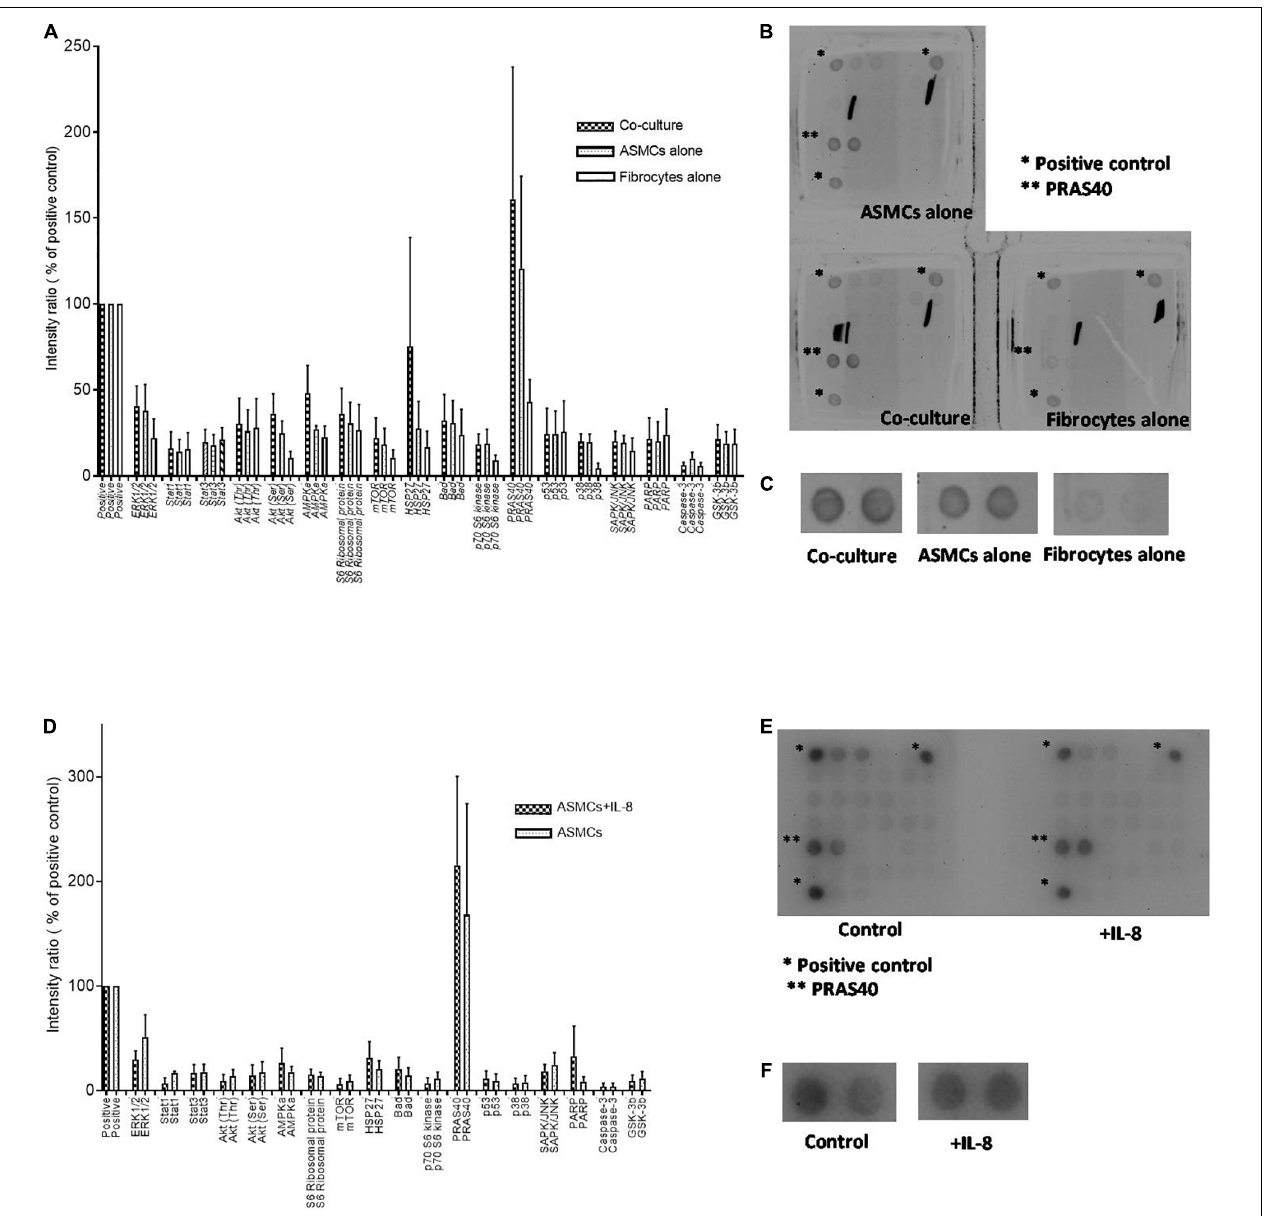
FIGURE 4 | (A) Intracellular signaling activation in ASMCs after 24-h stimulation by condition medium from co-culturing ASMCs and fibrocytes from asthmatic patients, culturing ASMCs alone, or culturing fibrocytes alone; ( n = 3). (B) The density of all signaling in ASMCs detected by array. Each signaling was done by duplication. ∗ : positive control. ∗∗ : PRAS40. (C) The enlarged picture of activation of PRAS40 in ASMCs stimulated with condition medium of co-culture, culturing ASMCs alone or culturing fibrocytes alone. The expression of PRAS40 in ASMCs treated with co-cultured condition medium was higher than that of the